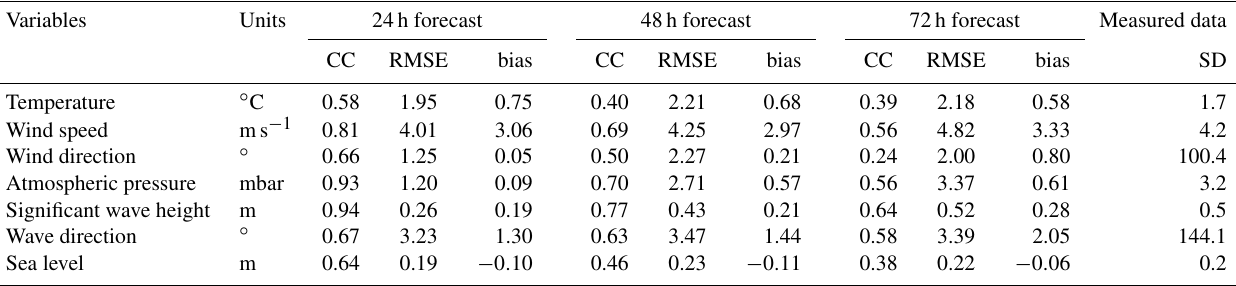
Table 5. Representative statistics that validate the numerical simulations of the forecasts of the WRF, WWIII, and ADCIRC models. The correlation coefficient (CC), root-mean-square error (RMSE), and bias of the analyzed variables are shown. The standard deviation (SD) of the measured data is also